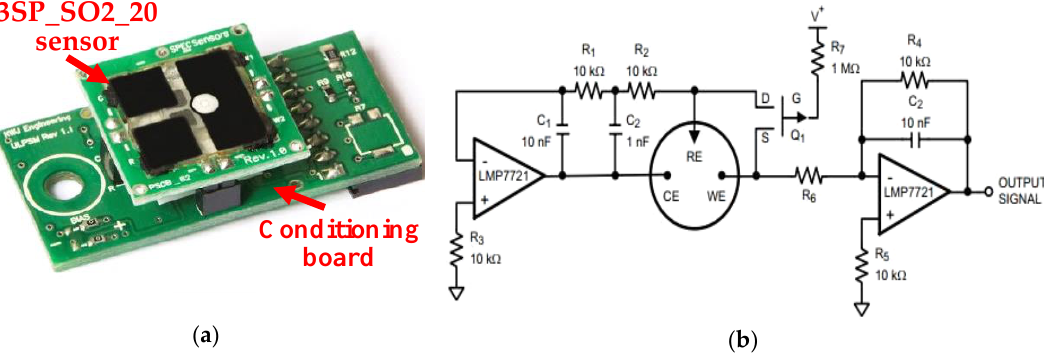
Figure 11. ULPSM-SO2 968-006 module constituted by 3SP_SO2_20 sensor (Spec Inc.) and the relative conditioning section ( a ), and potentiostatic circuit integrated in the conditioning board ( b ).